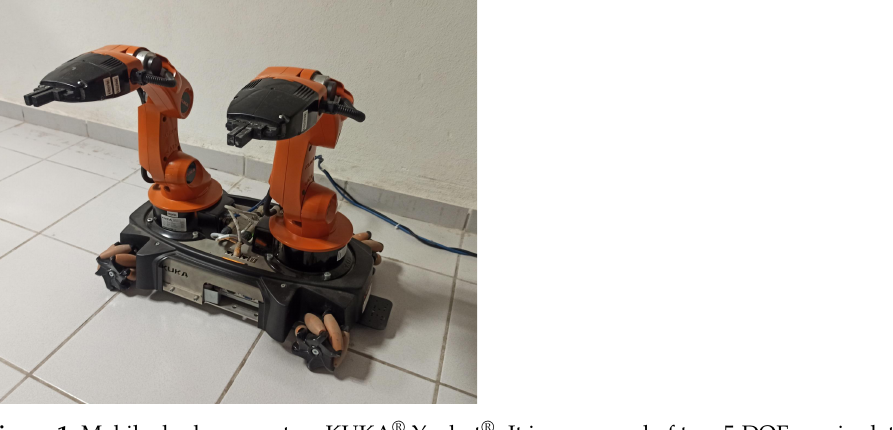
Figure 1. Mobile dual-arm system KUKA ® Youbot ® . It is composed of two 5-DOF manipulators and a 3-DOF mobile platform.